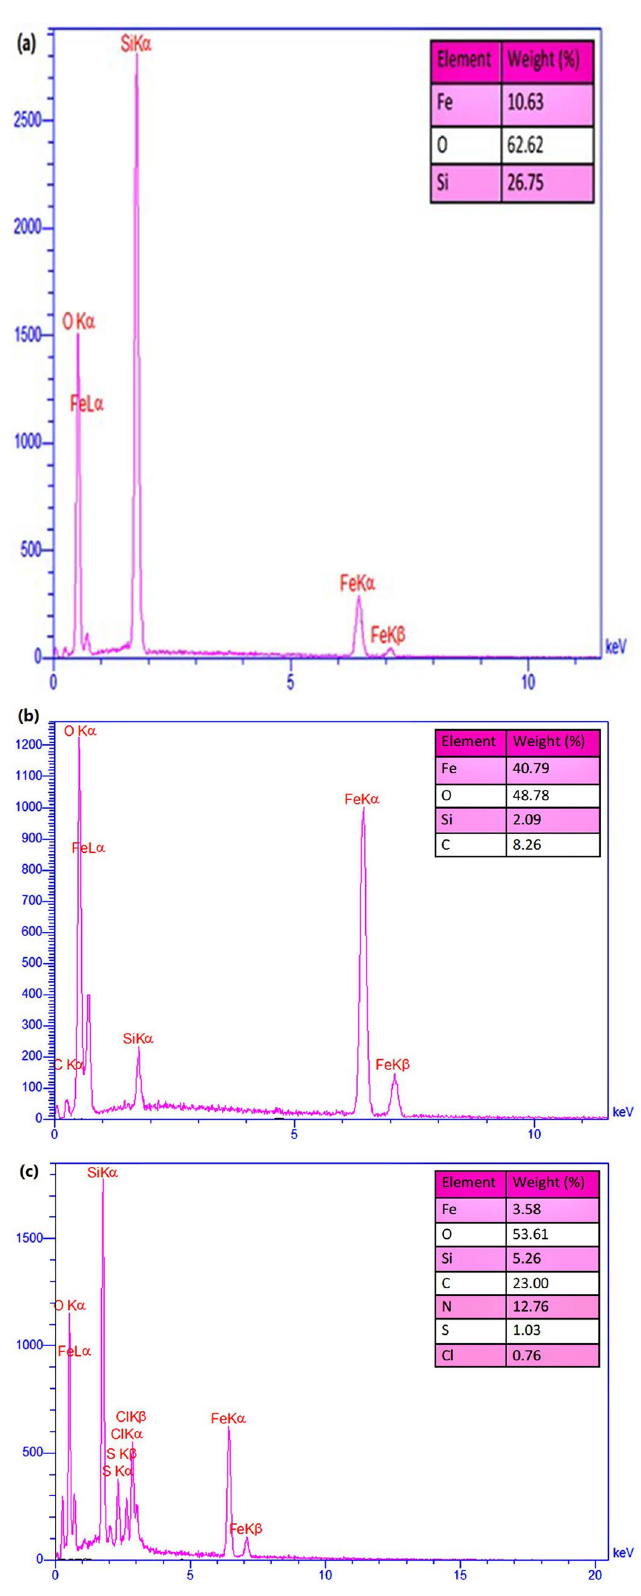
Figure 3. EDX spectra of ( a ) Fe 3 O 4 @SiO 2 , ( b ) Fe 3 O 4 @SiO 2 @vinyl, and ( c ) Fe 3 O 4 @SiO 2 /TABHA